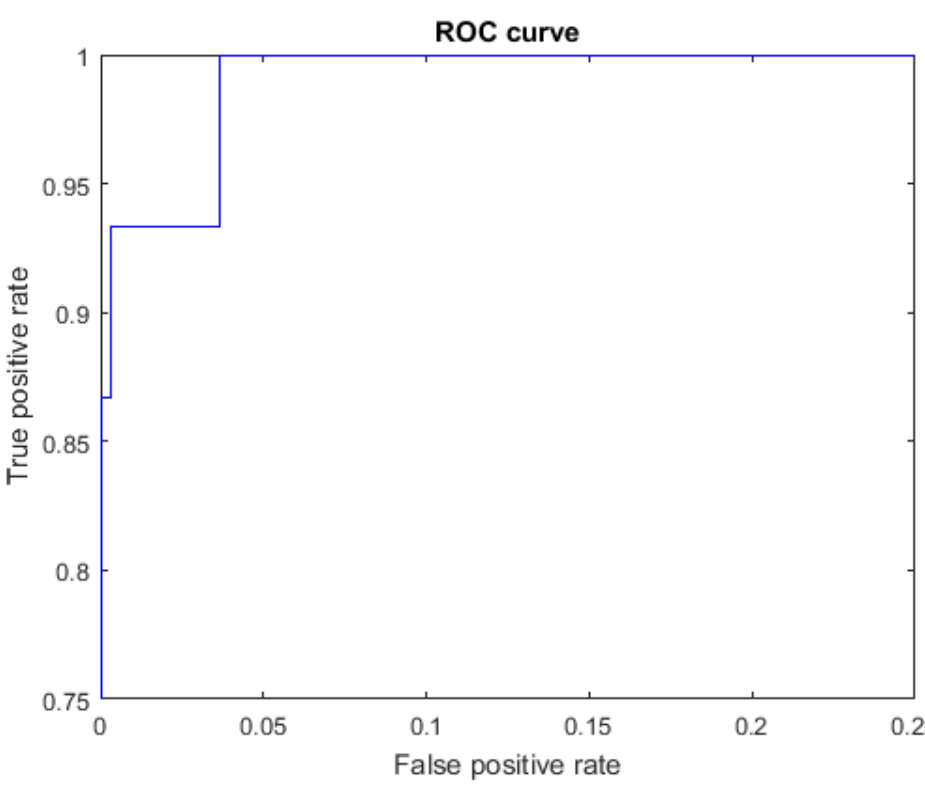
Figure 10. ROC curve for the letter S using spherical features, AUC = 0.9973.